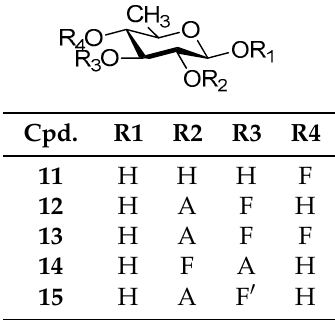
Figure 3. Structures of compounds 11 – 15 .